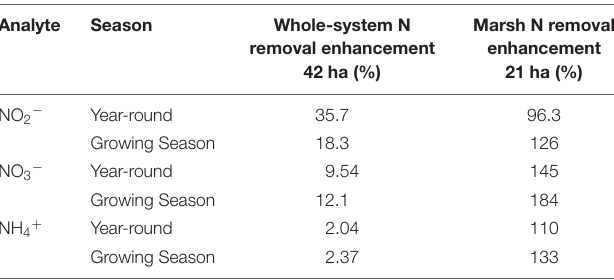
TABLE 2 | Enhanced N removal due to the Biological Tide (% improvement) for each dissolved inorganic nitrogen species at the whole system and marsh subsystem scales, where the Growing Season = March–September (modified from Treese et al., 2020). Analyte